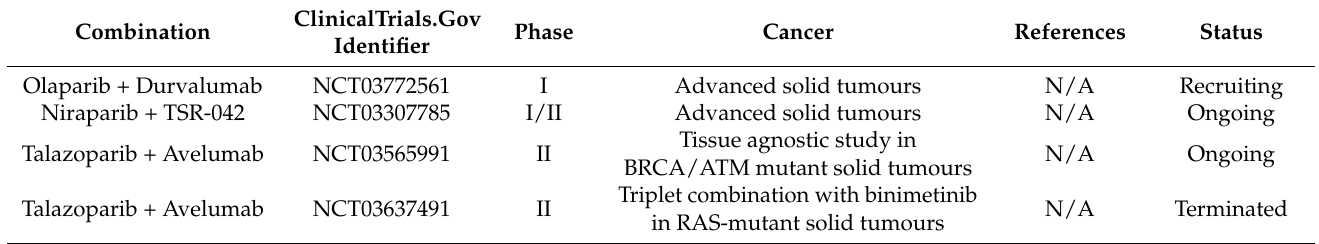
Table 2. “All-comer” studies combining PARP inhibitors and immunotherapy.